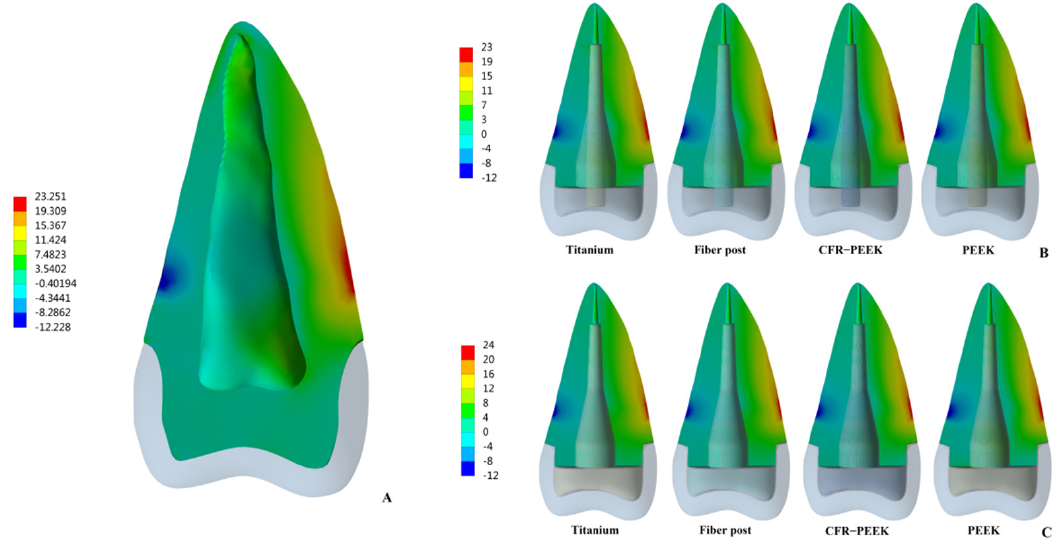
Figure 4. Distributions of MPS at roots. ( A ) Prototype 1. ( B ) Prototype 2. ( C ) Prototype 3.